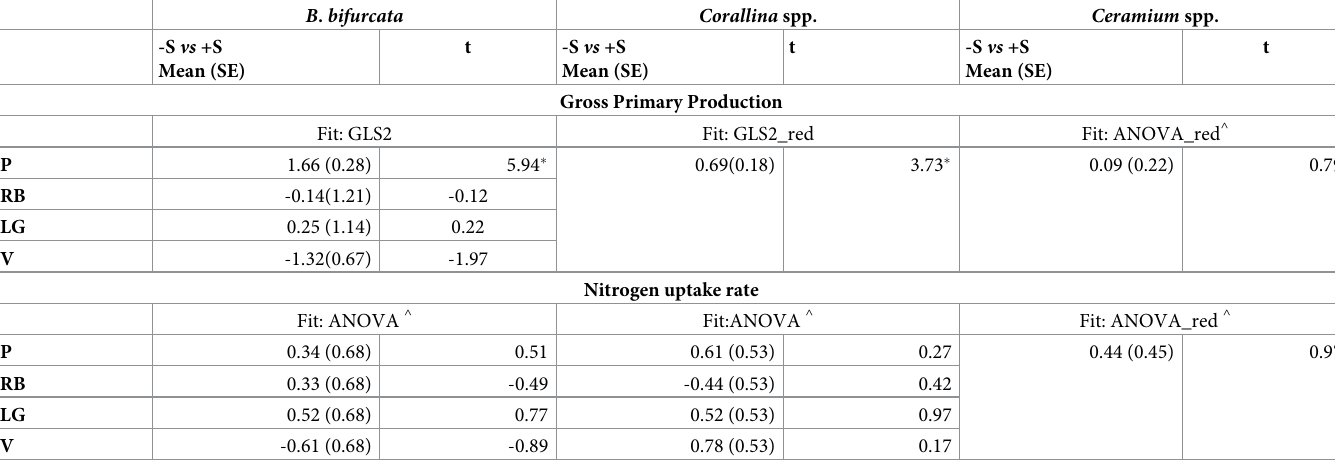
Table 3. Parameter estimates of the GLS models and t-tests for gross primary production and nitrogen uptake rate of the native macroalgae. B . bifurcata Corallina spp. Ceramium spp.